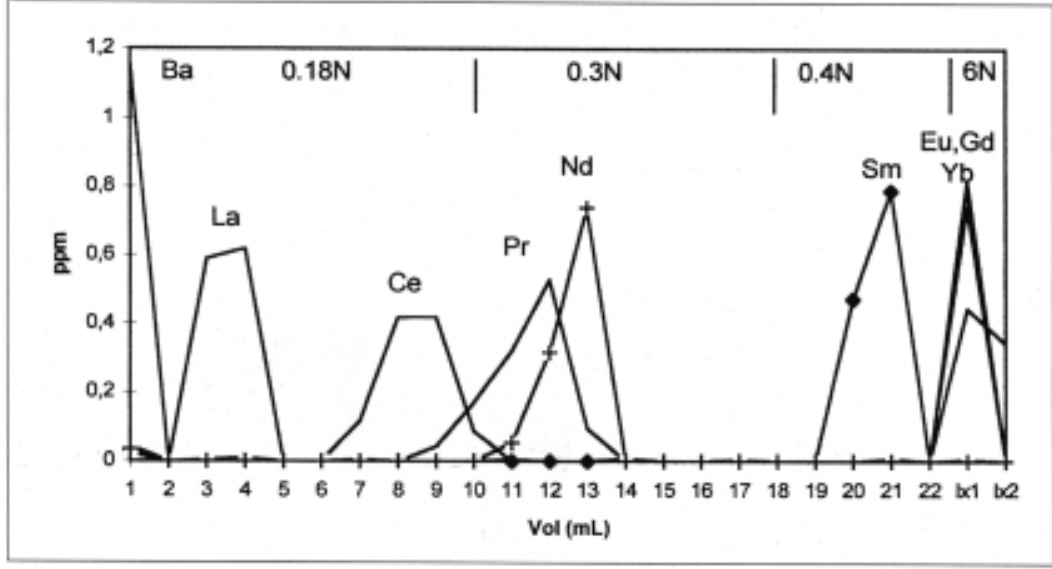
Fig. 2 – Sm and Nd separation. The calibration was made with LN-spec resin (HDEHP resin impregnated in teflon powder of 150-270 mesh). HCl was used as eluent in the